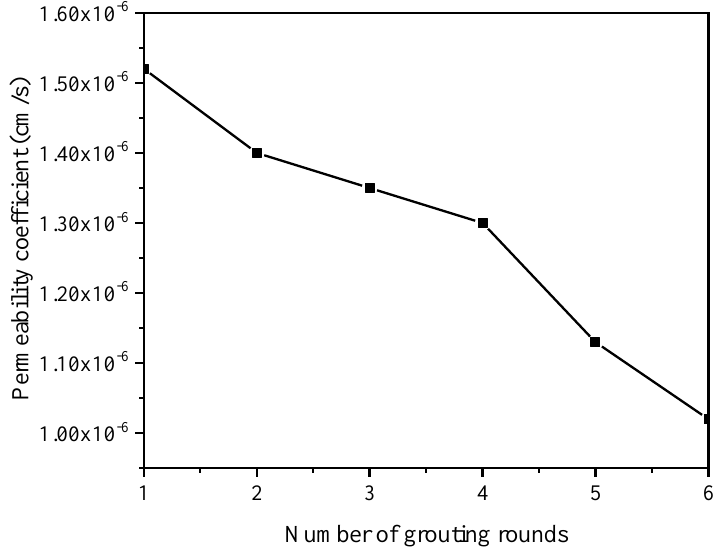
Figure 4. Permeability coefficient curve of samples with 1 – 6 rounds of grouting.